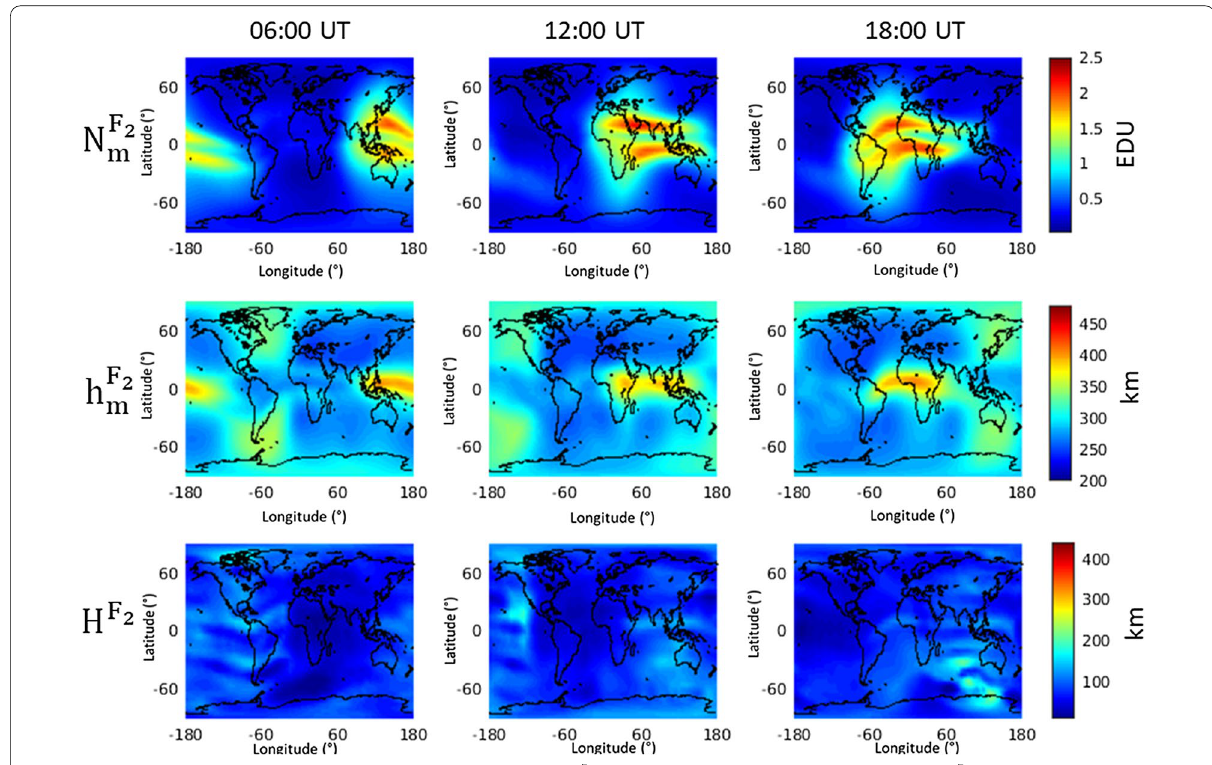
Fig. 6 Maps of the lower bound of the three key parameters κ 1 ; l = N F 2 m ; l (ϕ , (cid:31) ) for the peak density (top row), κ 2 ; l = h F 2 m ; l (ϕ , (cid:31) ) for the corresponding peak height (middle) and the scale height κ 3 ; l = H F 2 l (ϕ , (cid:31) ) (bottom) at three different time epochs on March 12,